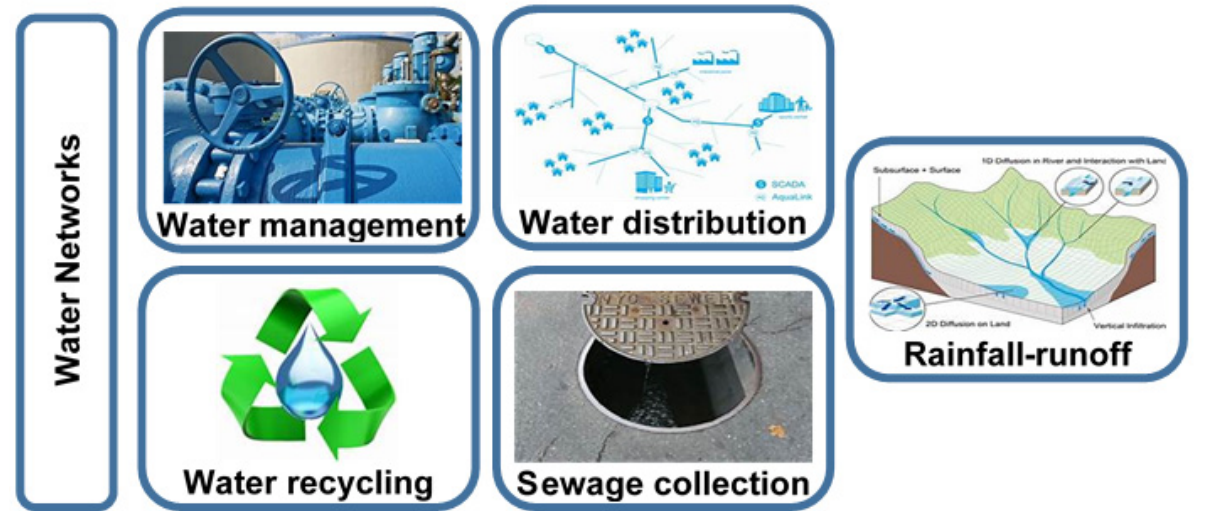
Figure 12. Water networks topics.